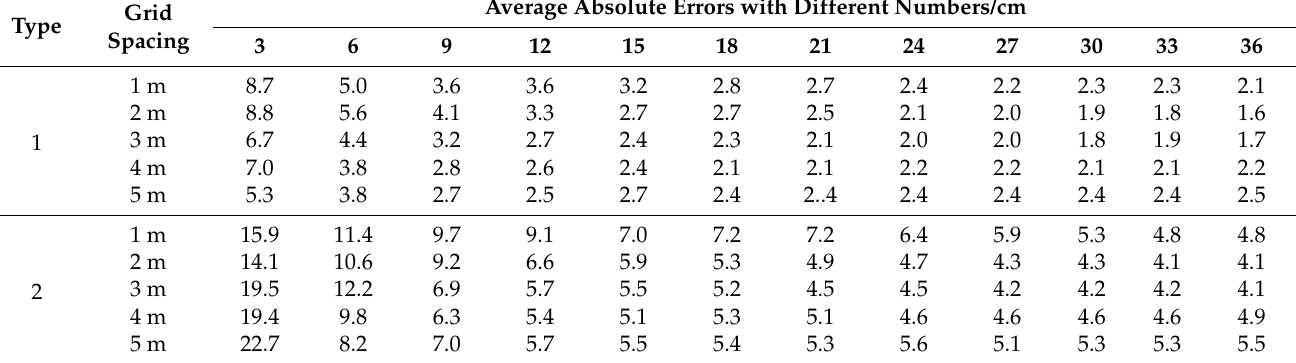
Table 1. Average absolute errors with different numbers.